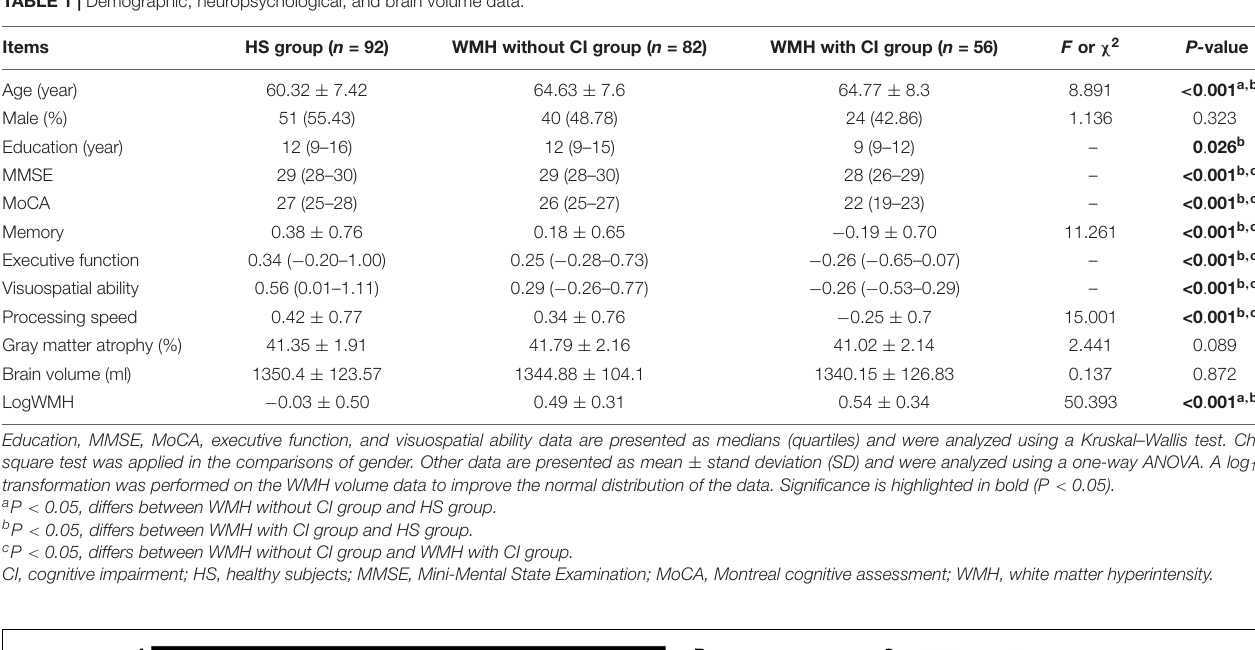
TABLE 1 | Demographic, neuropsychological, and brain volume data.